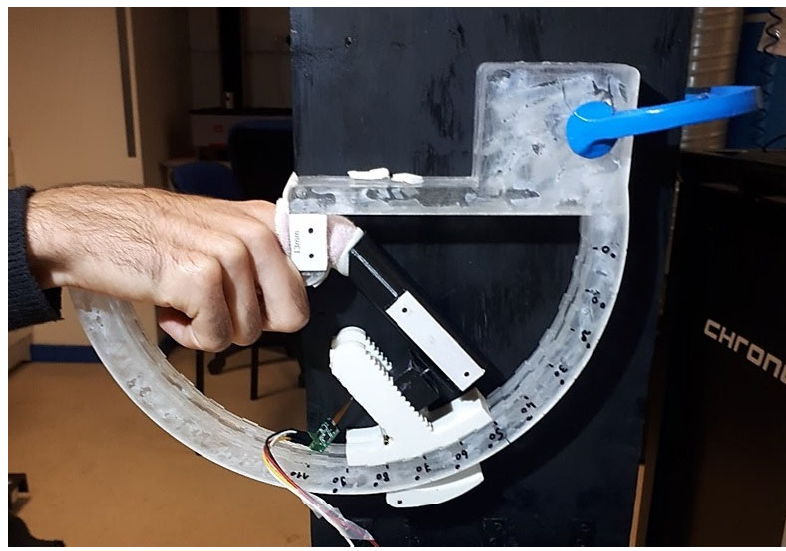
Figure 6. Hand positioned in the experimental device for a test with an angle of α =